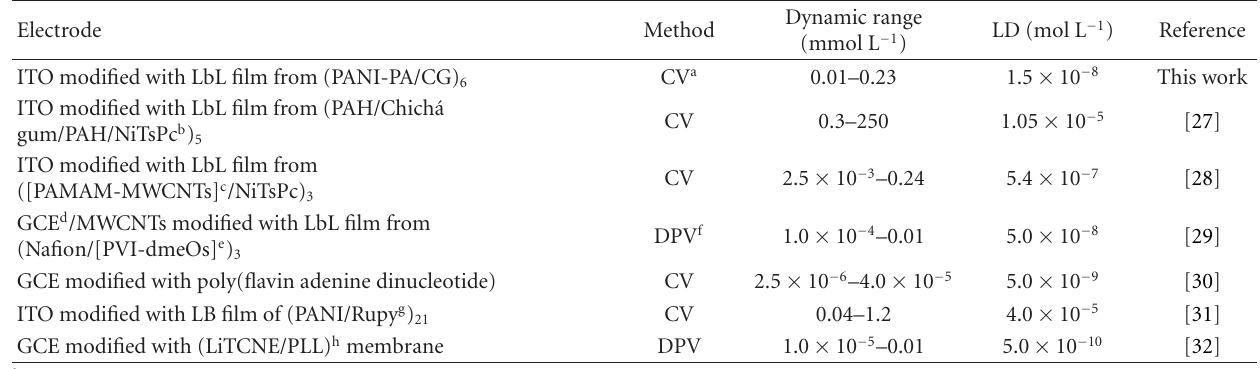
Table 1: Comparative performance of di ff erent electrodes for dopamine determination.